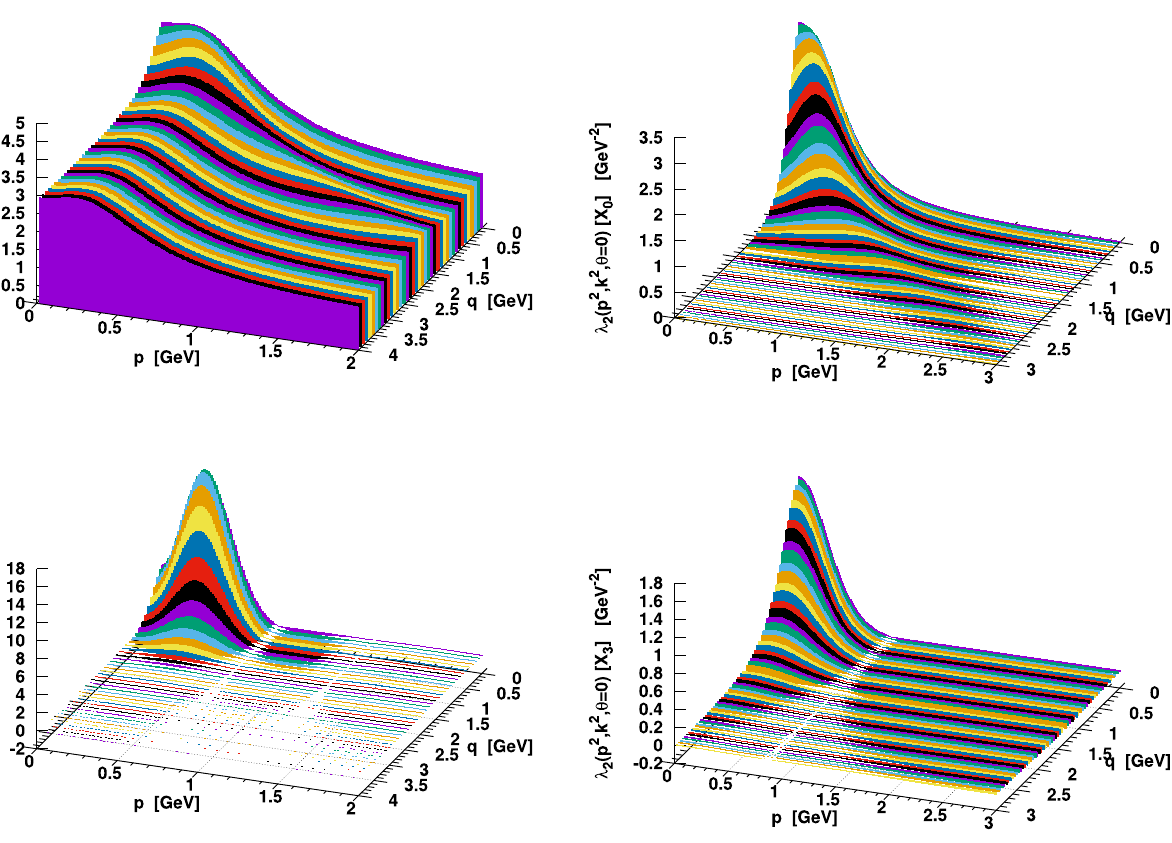
Fig. 7 The contribution proportional to X 0 (left) and to Y 3 to the form factor λ